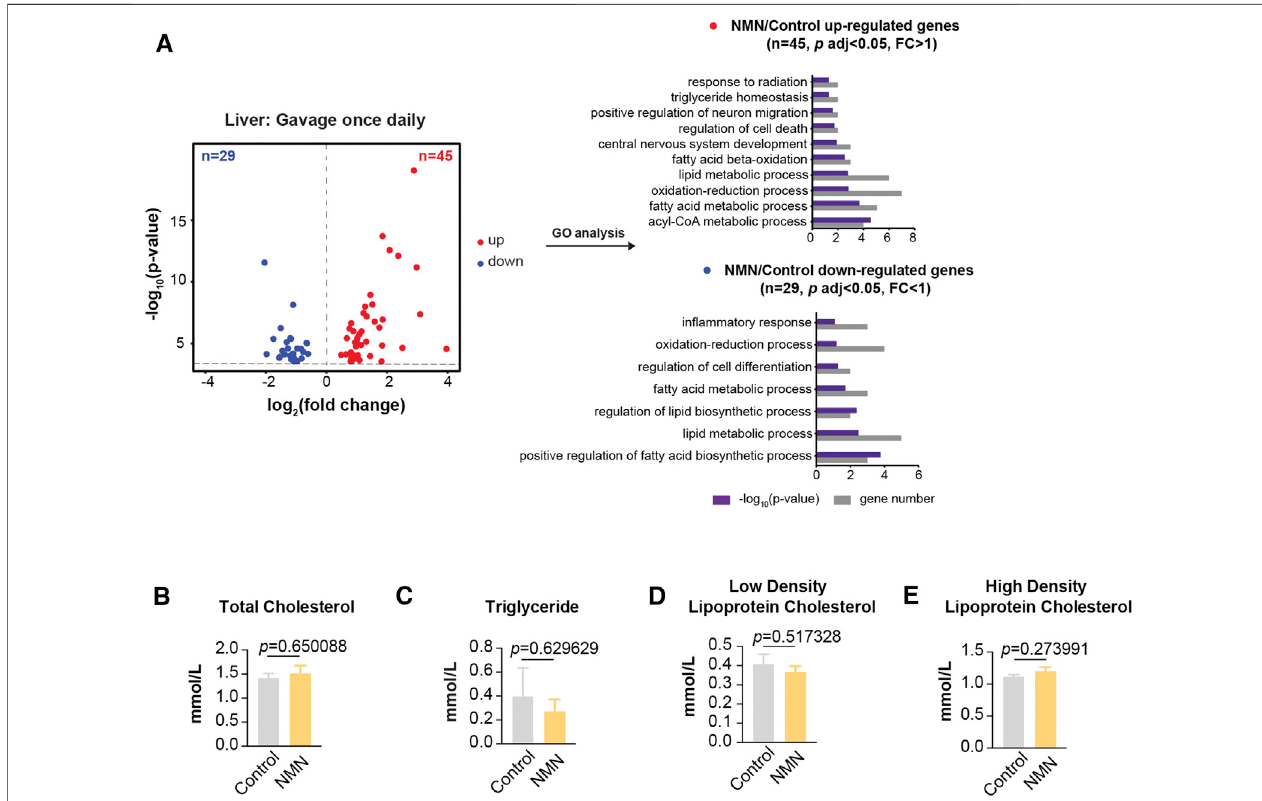
FIGURE 4 | Transcriptomic Analysis in 1340 mg/kg/d NMN-Administrated Mice Liver (A) Volcano plot shows that genes are differentially expressed in 1340 mg/kg/d NMN-administrated mice compared to control in liver (left panel) . Differential expression analysis was performed by DESeq2 from four biological replicates.45geneswerefoundtobeupregulated ( p < 0.05,FC > 1), 29genesweredownregulated( p < 0.05,FC < 1).Geneontology(GO)analysiswereperformedby David (right panel) . The result shows lipid metabolic process being the biological processes signi fi cantly enriched for genes up and down regulated in 1340 mg/kg/d NMN administration group. The bar graphs represent – log10 ( p value) and gene counts in each pathway. (B – E) Blood lipids were measured after 1340 mg/kg/d NMN administration.